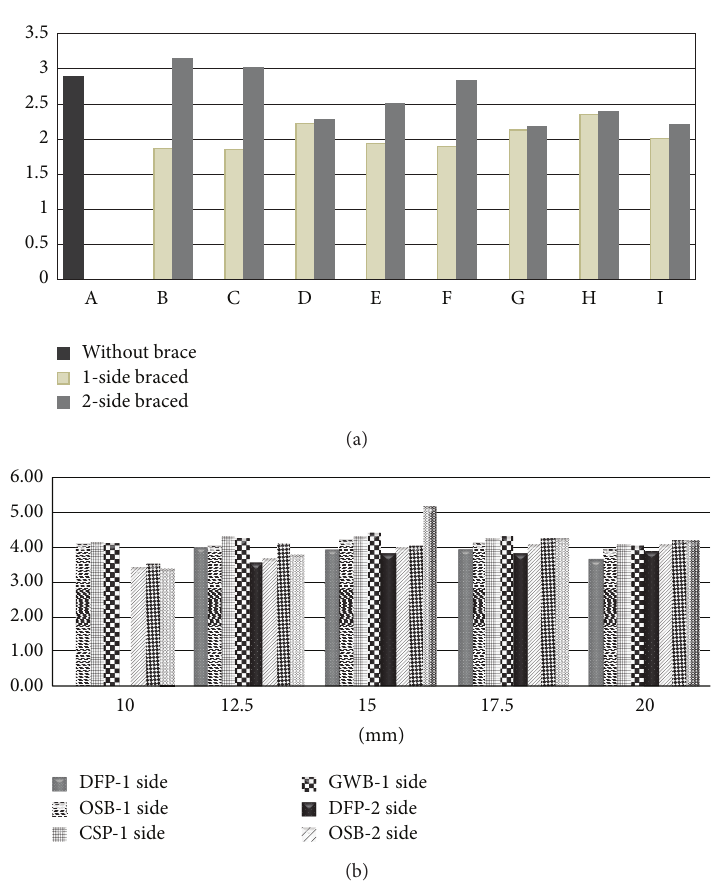
Figure 13: Comparing values of response modification factors. (a) Braced walls. (b) Sheeting